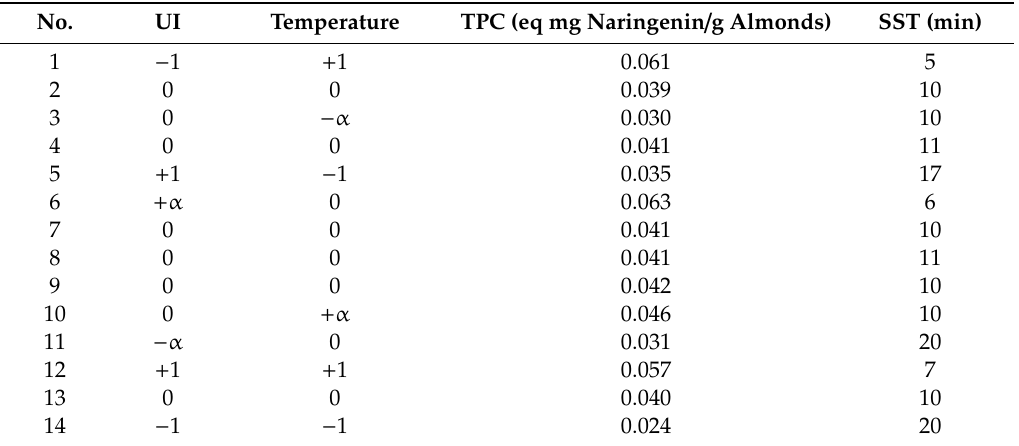
Table 1. Fully coded Central Composite Design (CCD) and responses obtained for Total